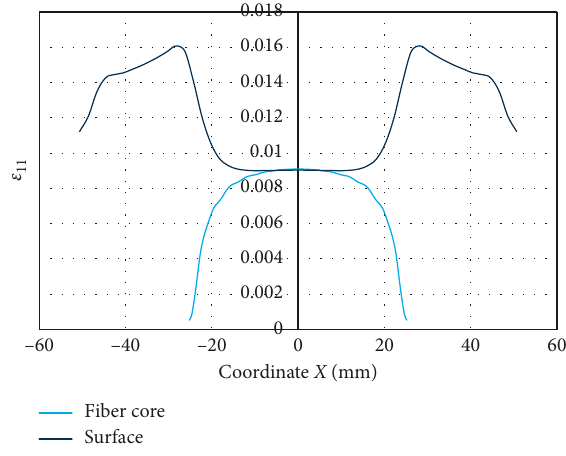
Figure 7: Strain value ε 11 in case when the fiber is located between the composite plies and attached to the surface through the ad- hesive